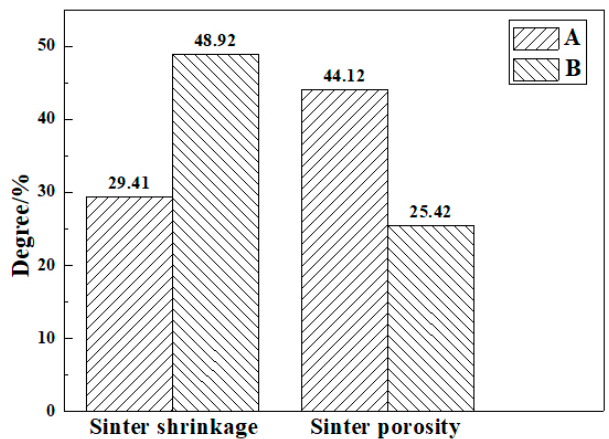
Figure 7. Porosity and shrinkage of the product sinter of di ff erent sintering processes ( A ) Traditional sintering process, ( B ) Pressurized densification sintering